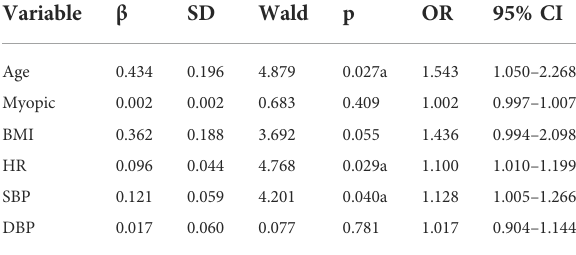
TABLE 2 Results of logistics regression